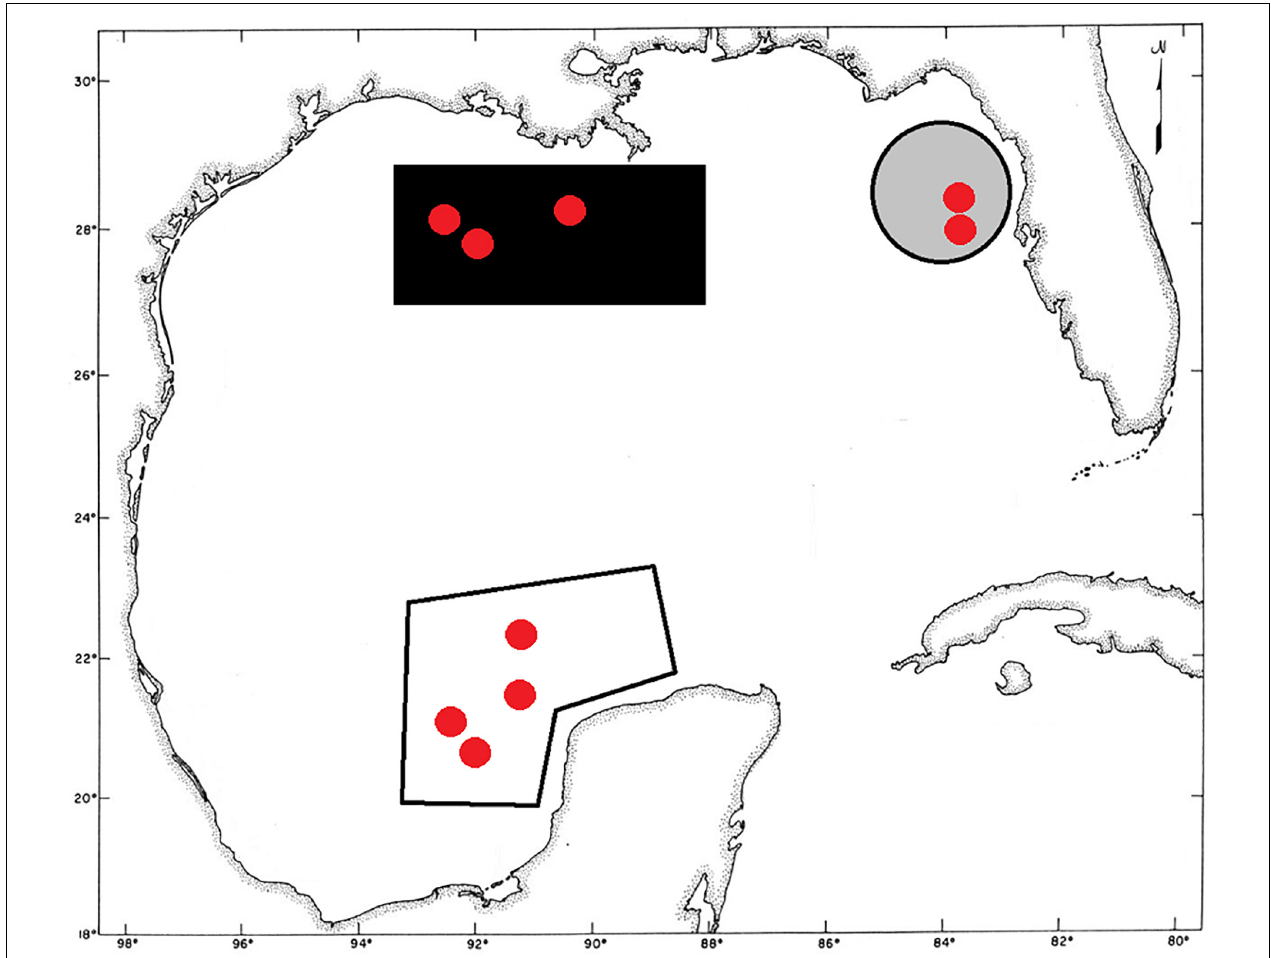
FIGURE 2 | Map of the Gulf of Mexico (GoMx) indicating the three regions evaluated in this study which include most of the offshore banks and reefs surveyed across the basin. The southernmost region (white) corresponds to the Campeche Banks; the easternmost region corresponds to the Florida Middle Grounds (gray); and the NW region (black) corresponds to the offshore banks of Louisiana (black). The collection sites are presented as red points. The coordinate grid shows the position for even degrees of longitude and latitude; two degrees of longitude cover a distance of ∼ 201.5 km at the GoMx